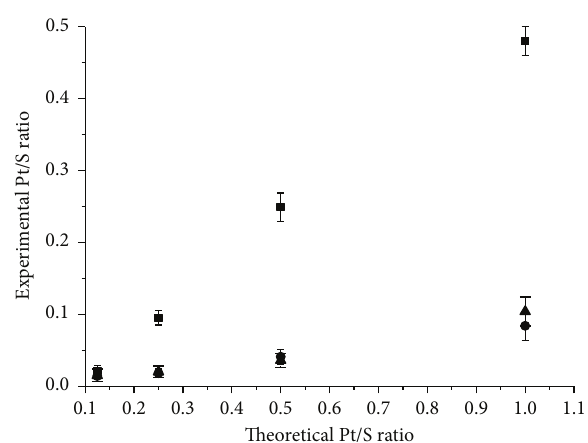
Figure 2: Experimental versus theoretical Pt/S molar ratios for the interaction between 1 (triangles), 2 (circles), and 3 (squares) with DS